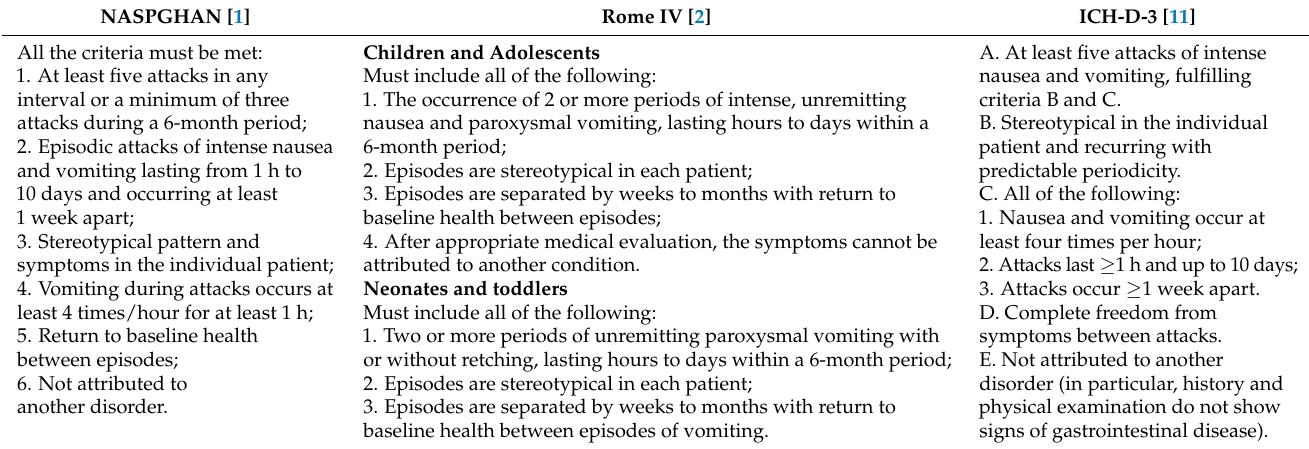
Table 1. Current classification for the diagnosis of cyclic vomiting syndrome